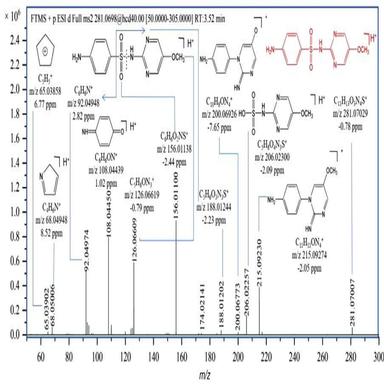
Product ion spectrum and proposed fragmentation pattern of SME.